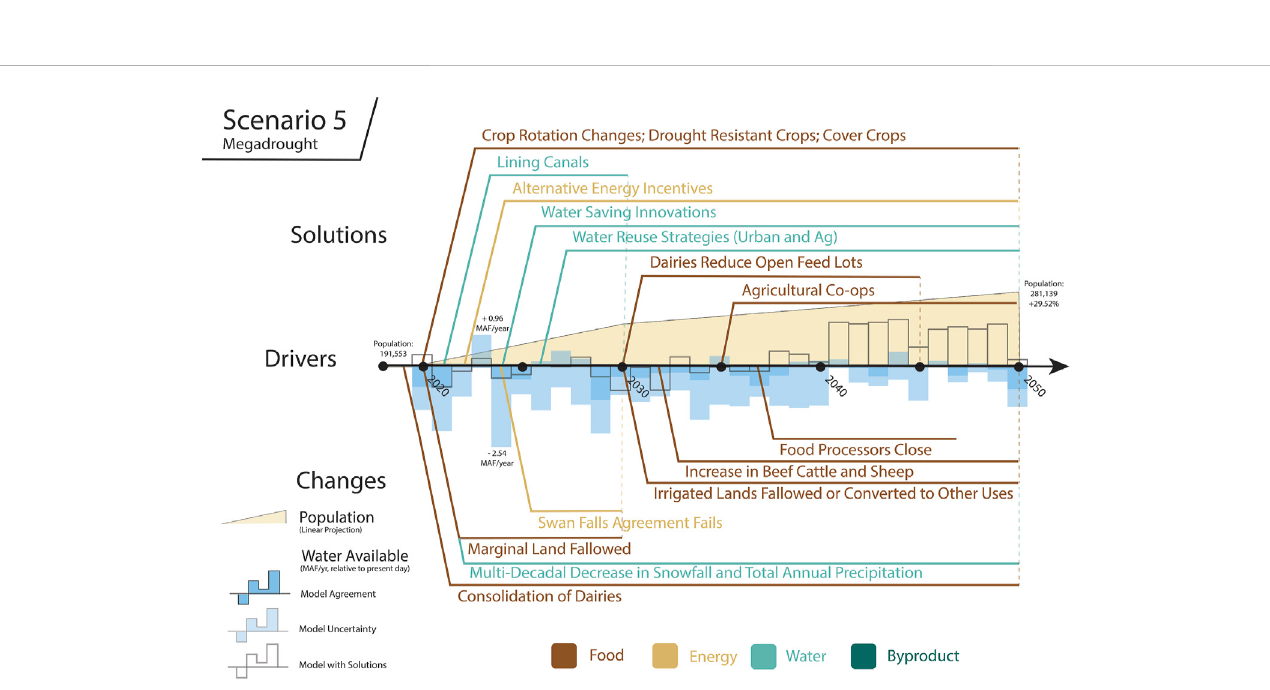
FIGURE 4 Representation of the solution development process from scenario narratives, to coupled biophysical modeling, to development of solutions and modeling the impacts of solutions. “ Model agreement ” refers to the average of multiple climate model runs, “ model uncertainty “ indicates the variability between those model runs, and “ model with solutions ” indicates the water available once the identi fi ed solutions are implemented (see Cronan et al., 2022b for more information). For more details on the coupling of models, see Cronan et al., 2022b. For more on the coproduction process see Kliskey et al. (In